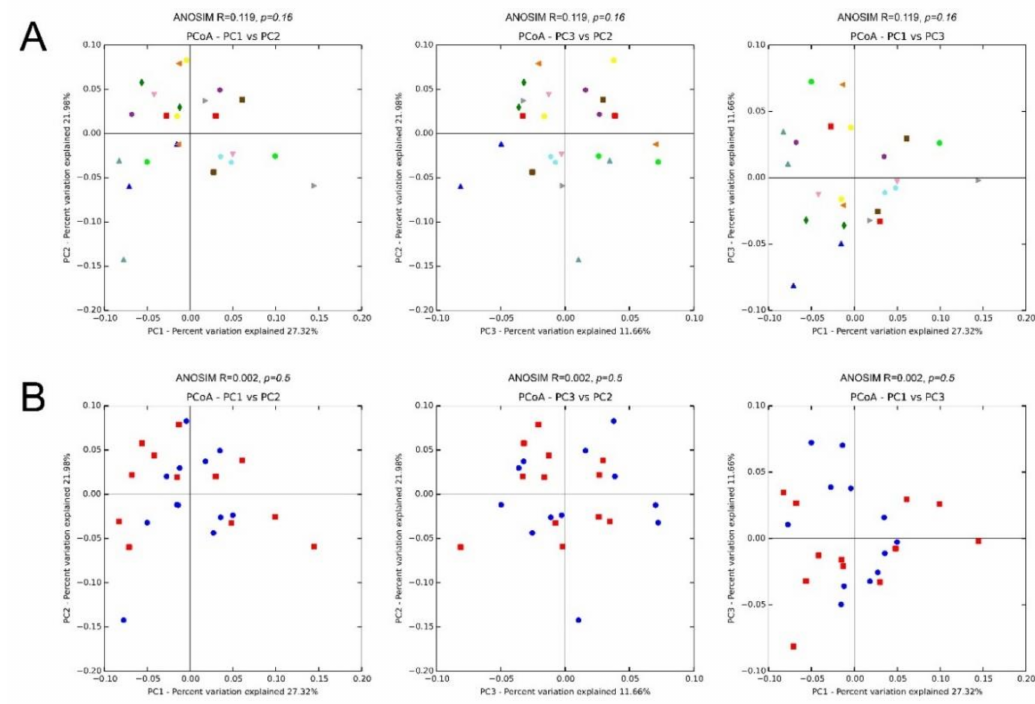
Figure 8. Microbiota β diversity (between-sample microbial diversity) based on principal coordinate analysis (PCoA) of weighted UniFrac distances. Two-dimensional PCoA plots display inter-sample distances by three principal coordinates (PC1, PC2, and PC3) with labeling of individual samples by patient ( A ) and treatment ( B ), for patients 1 to 12. Principal coordinates, calculated from a distance matrix of weighted Unifrac distances and have no